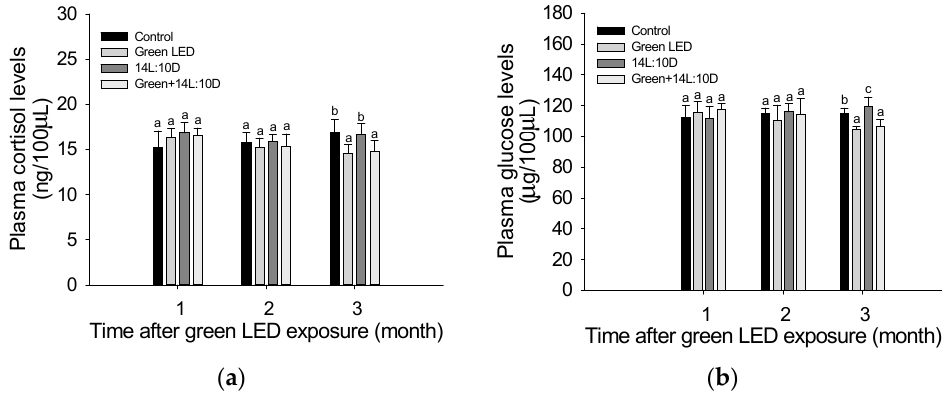
Figure 4. Chub mackerel, Scomber japonicus , were exposed to a 12 h light and 12 h dark photoperiod, either under fluorescent lighting (Control) or under green LEDs (Green LED); mackerel were also exposed to an extended 14 h light and 10 h dark photoperiod under fluorescent lighting (14L:10D) or green LEDs (Green+14L:10D). Blood was drawn from the caudal veins of fish (n = 40; full length, 33.7 ± 3.5 cm; weight, 453.5 ± 10.4 g per group) and subjected to immunoassay via ELISA kits to measure plasma levels of ( a ) cortisol and ( b ) glucose at onset of the experiment, after 1 month, and after 2 months. Vertical bars denote standard errors. Values with different superscripts (a, b, or c) within a given observation period indicate significant differences between groups ( p < 0.05) as determined using Tukey’s multiple range